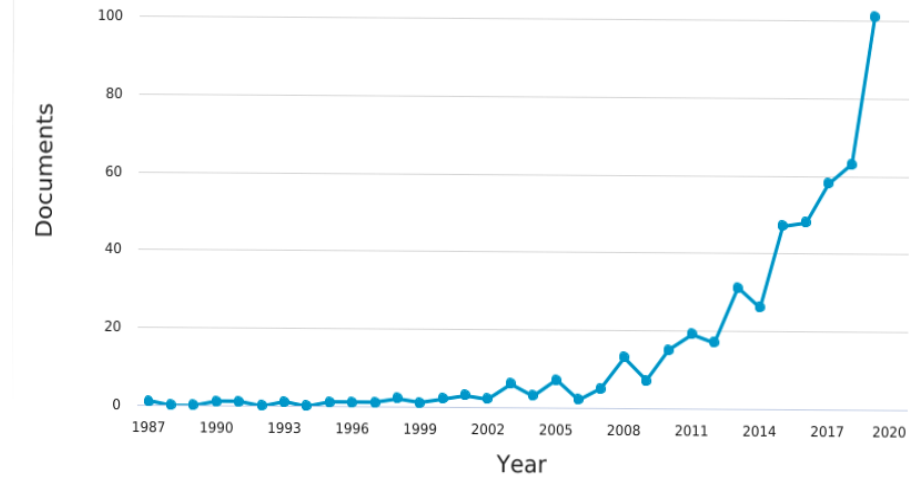
Figure 7. Evolution of Considering Occupant Behavior Within Data Driven